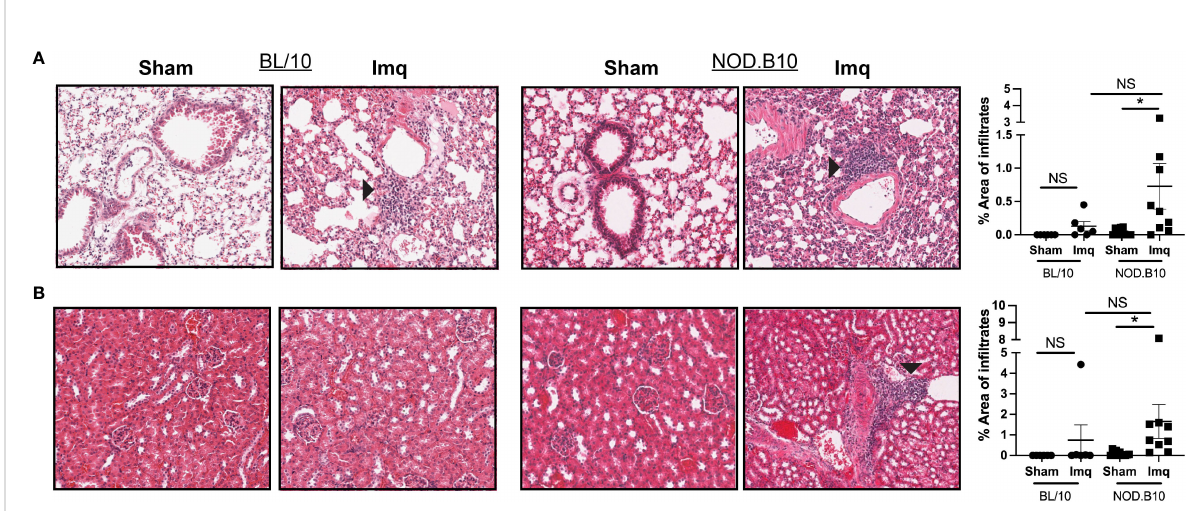
FIGURE 3 TLR7 agonism induces signi fi cant pulmonary and renal in fl ammation in pSS mice. (A) Lung and (B) kidney tissues were harvested from sham (n = 10) or Imq-treated female pSS mice (n = 9) and from sham (n = 6) or Imq-treated age and sex-matched controls (n = 6). One representative photomicrograph is shown from each group. Lymphocytic in fi ltration was quanti fi ed using ImageJ and black arrows indicate tissue in fl ammation. Horizontal lines represent the mean and SEM (NS = non-signi fi cant, *p <